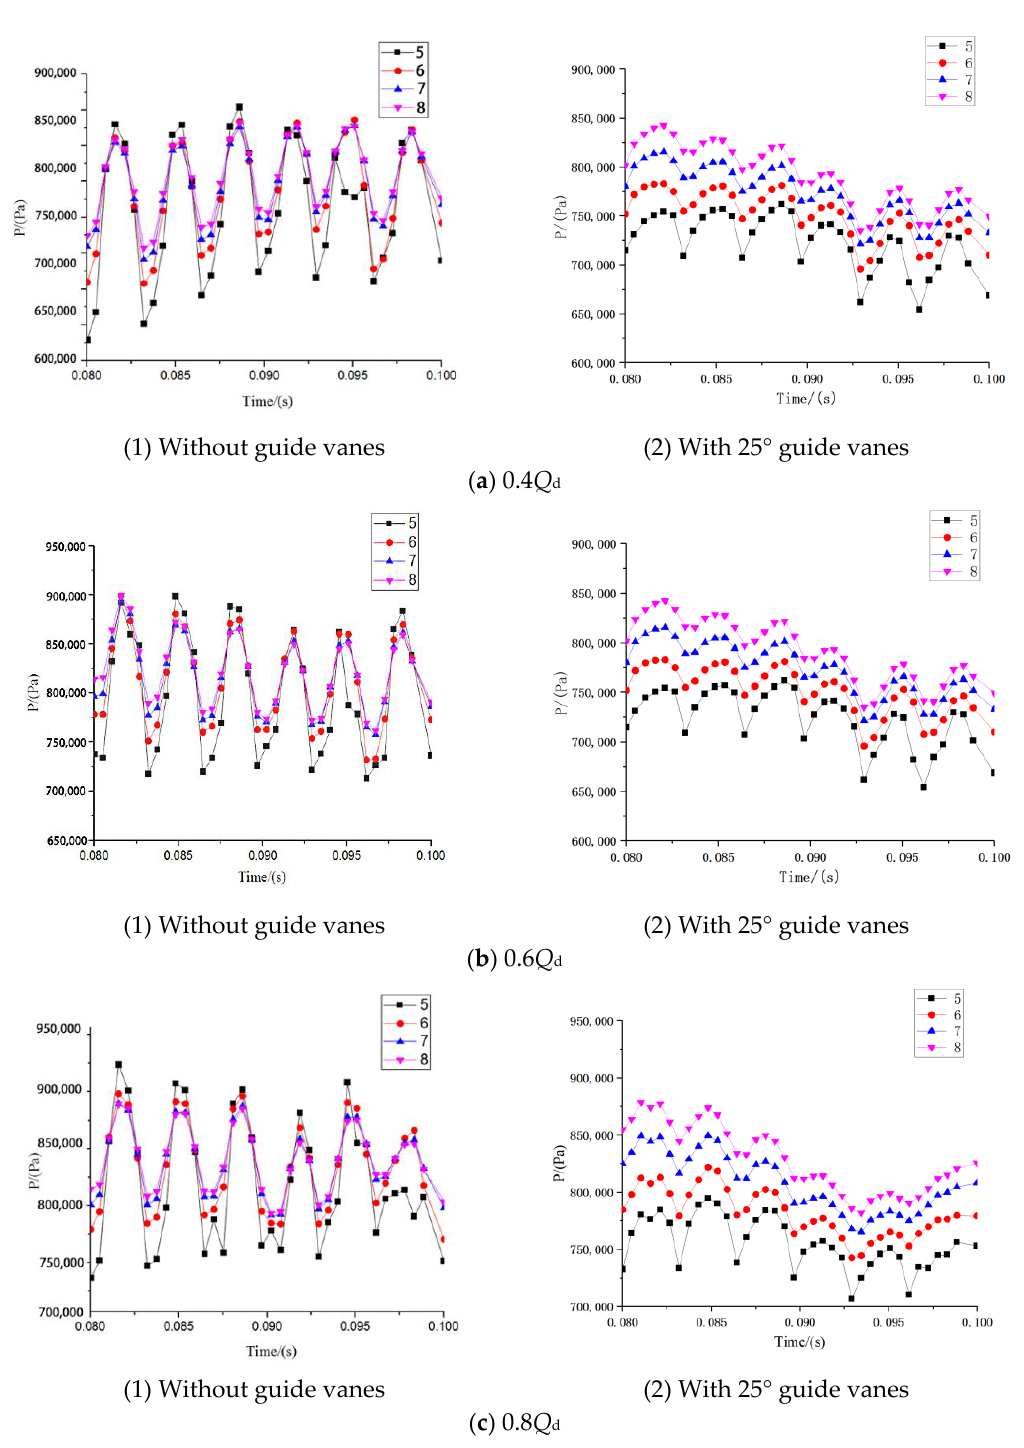
Figure 13. Static pressure distribution of section VIII for different flow rates: ( a ) 0.4 Q d , ( b ) 0.6 Q d , ( c ) 0.8 Q d.